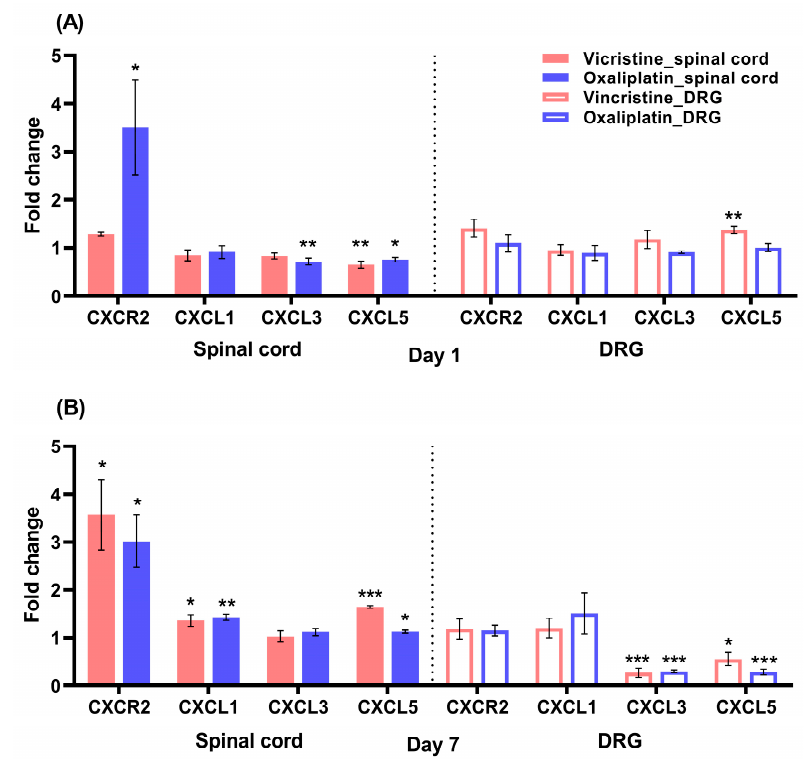
Figure 2. ( A ) Real-time quantitative PCR results showing mRNA expression levels of CXCR2, CXCL1, CXCL3, and CXCL5 in the lumbar spinal cord and DRG after the 1st day from the first injection of either vincristine or oxaliplatin (n = 4). ( B ) mRNA expression levels of targets in the lumbar spinal cord and DRG after the 7th day from the first injection of either vincristine or oxaliplatin (n = 4). All the expression levels were normalized to the amount of GAPDH and were compared to the sham group. Results are presented as the mean relative fold change ± SEM (* p ≤ 0.05, ** p ≤ 0.01, *** p ≤ 0.001, ANOVA followed by Bonferroni post hoc test). 2.3. Inhibition of CXCR2 with Reparixin Prevents Oxaliplatin-Induced CIPN In order to determine whether CXCR2 blockade in the spinal cord is involved in the development of CIPN, reparixin, a CXCR1/2 inhibitor, was intrathecally administered along with oxaliplatin or vincristine. After measuring the baseline of the PWT on day 0, reparixin was injected (n = 5) intrathecally on the 2nd, 4th, and 6th days after measuring the PWT. The PWT measured on the 7th day was 0.244 ± 0.064 g in mice with vincristine administration and 0.276 ± 0.022 g in mice with vincristine and reparixin administration, showing no significant effect of reparixin administration on vincristine-induced neurop- athy. Meanwhile, the PWT following oxaliplatin-induced mechanical allodynia was 0.196 ± 0.027 g, which was significantly inhibited by reparixin administration, with a PWT of 0.800 ± 0.080 g (Figure 3A). These results suggest that CXCR2 in the spinal cord was in- volved in the development of oxaliplatin-induced neuropathy but not vincristine-induced neuropathy. Next, we studied whether the intraperitoneal administration of reparixin, a drug known not to cross the blood–brain barrier (BBB) [34], could prevent CIPN (n = 4). Similar to the results of the intrathecal administration of reparixin, oxaliplatin-induced neuropa- thy was blocked by reparixin administration from 0.263 ± 0.023 g to 0.883 ± 0.010 g, but